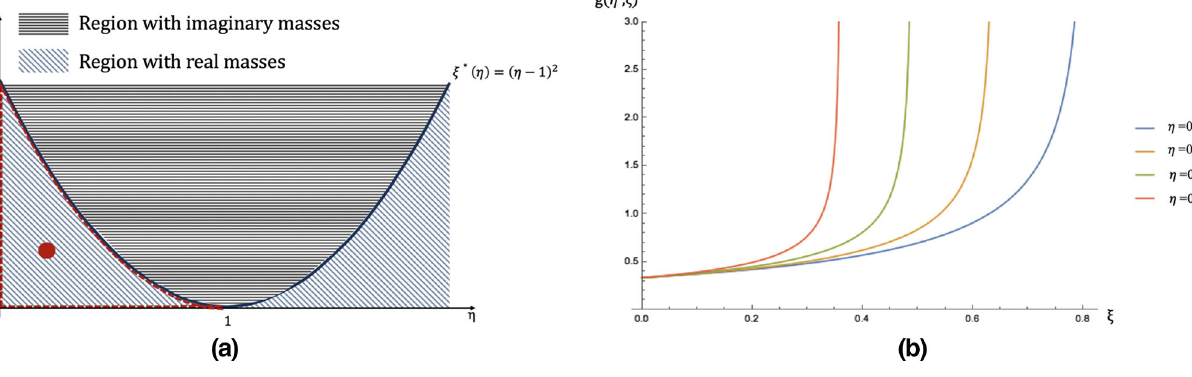
Fig. 5 a Models with the structure f ( R , φ) + ω(φ)φ ; α φ ; α can be represented in η ξ − plan as the generic point (red): { (η,ξ) | η < 1 , 0 < ξ < ξ ∗ (η) } ; b graph of the function g (η,ξ) with η <